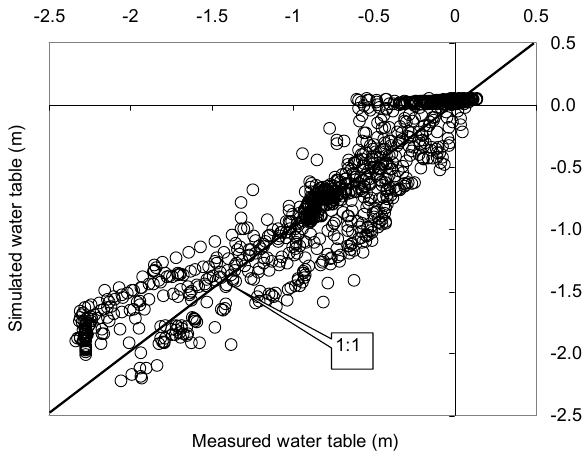
Fig. 7b. Water table depth at well W3 and W7 in 2004–2005.